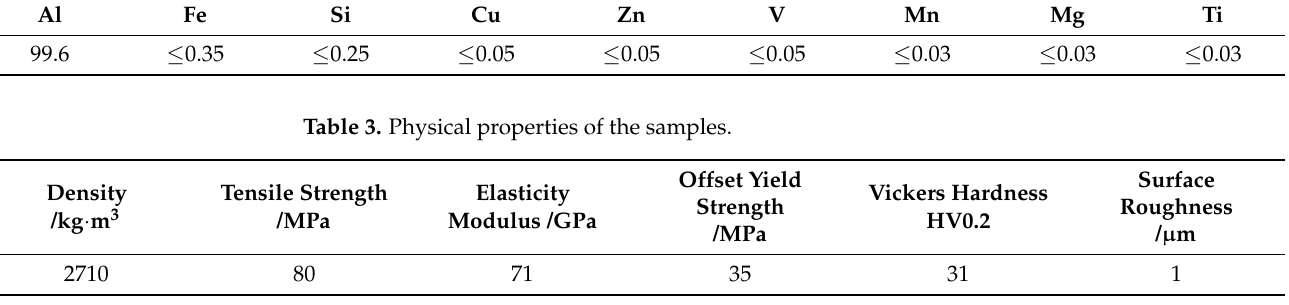
Figure 5. Dimensionless cumulative cavitation intensity after the time integral.